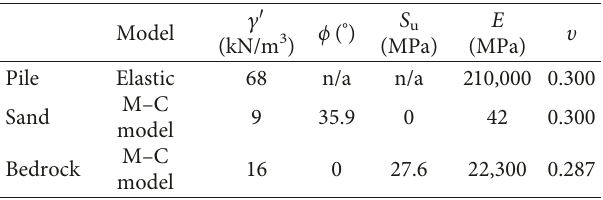
Table 1: Material properties used in the